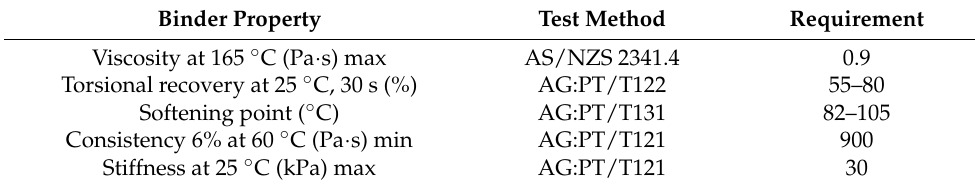
Table 5. Properties of A15E polymer modified binder [34].